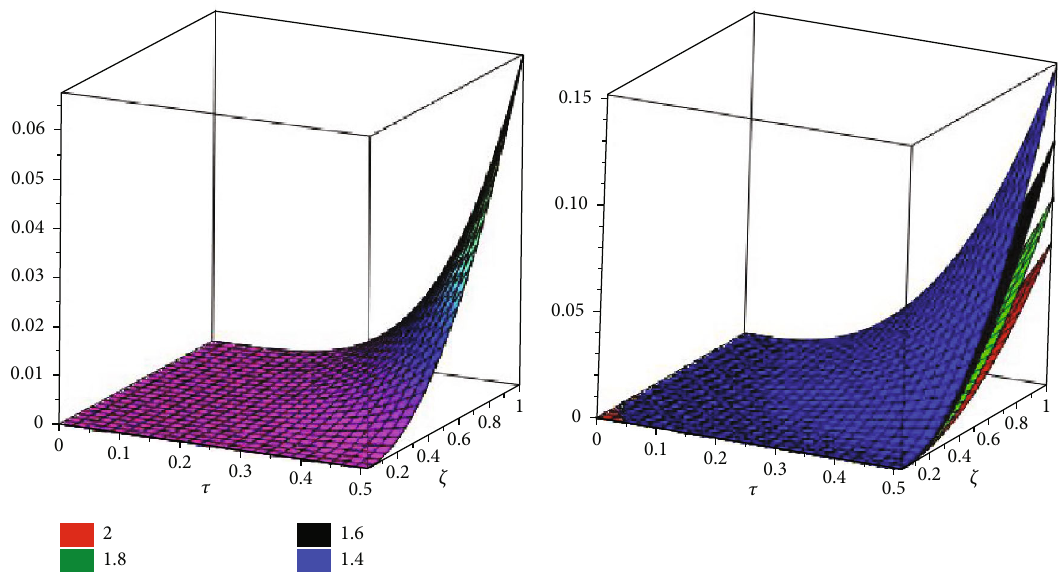
Figure 6: The exact and an approximate graph and di ff erent fractional-order graphs of problem